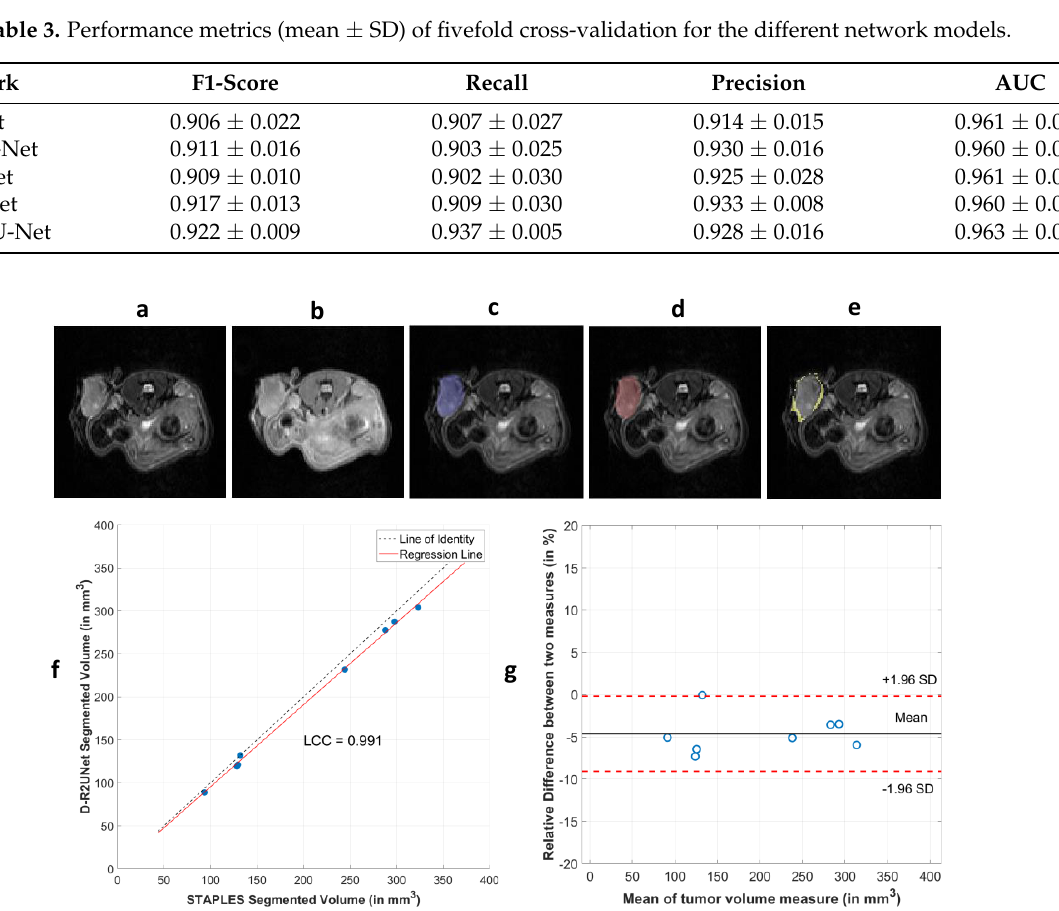
Figure 4. Results from the CNN segmentation by using multi-contrast MR imaging: ( a ) single slice of T2w image, ( b ) single slice of T1w image, ( c ) segmentation map derived from all the manual experts by using a EM-based algorithm called STAPLE (ground truth), ( d ) segmentation map generated by D-R2UNet, ( e ) the difference map of the D-R2UNet (algorithm) relative to the STAPLE(manual) ( f ) Lin’s concordance correlation plot between the tumor volume segmented from the D-R2UNet algorithm in relation to that of STAPLE, ( g ) BA plot between the tumor volumes segmented by D-R2UNet vs. STAPLE. The relative difference is expressed in percentage relative to ground truth and mean volume change is 4.6%.